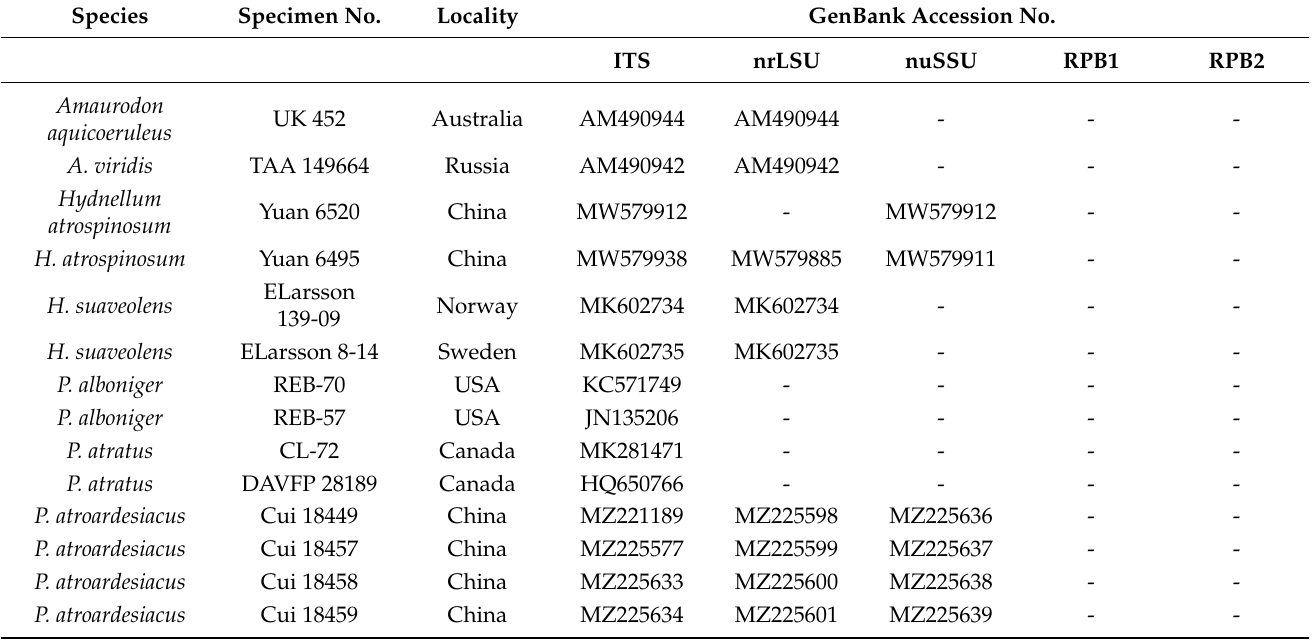
Table 1. A list of species, specimens, and GenBank accession numbers of sequences used in this study.